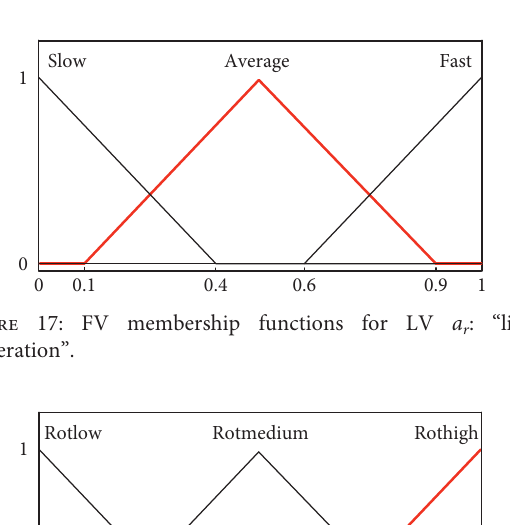
r : “linear velocity”.